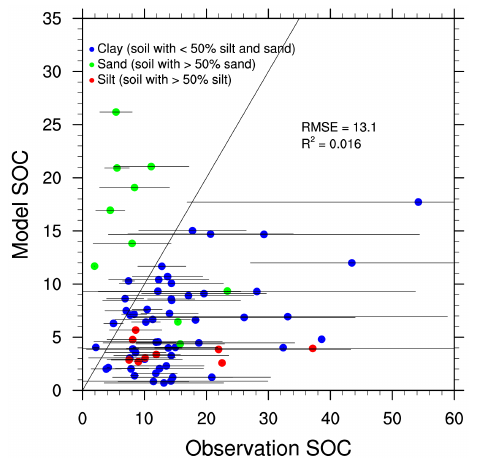
Figure 3. CLM-modeled SOC (kgCm − 2 ) versus ISCN observa- tions for model-derived soil texture types clay, sand, and silt. Each point represents the mean observed SOC value in the grid cell; error bars show the standard deviation. The black line represents the 1:1 ratio.